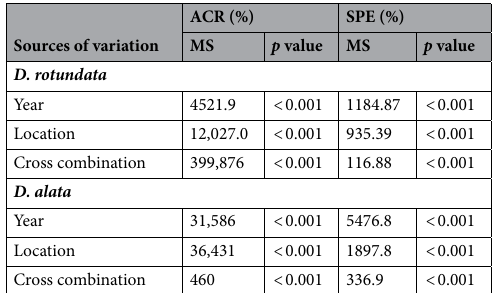
Table 3. Summary ANOVA of the influence of year, location, and cross-combinations on pollination success at IITA (2010–2020). ACR = average cross-compatibility/crossability rate, SPE = seed production efficiency, MS = mean